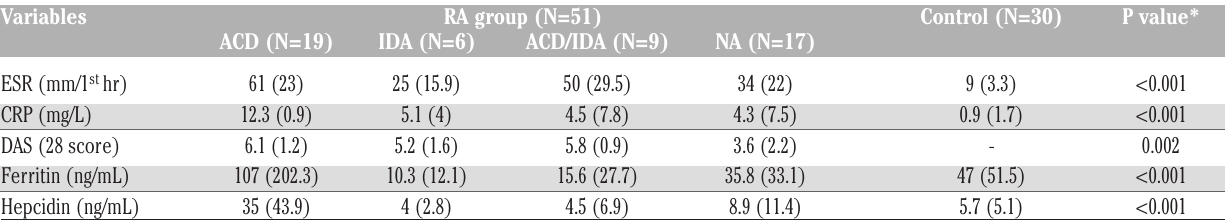
Table 3. Acute inflammatory markers and DAS 28 score in the study group (n=81).